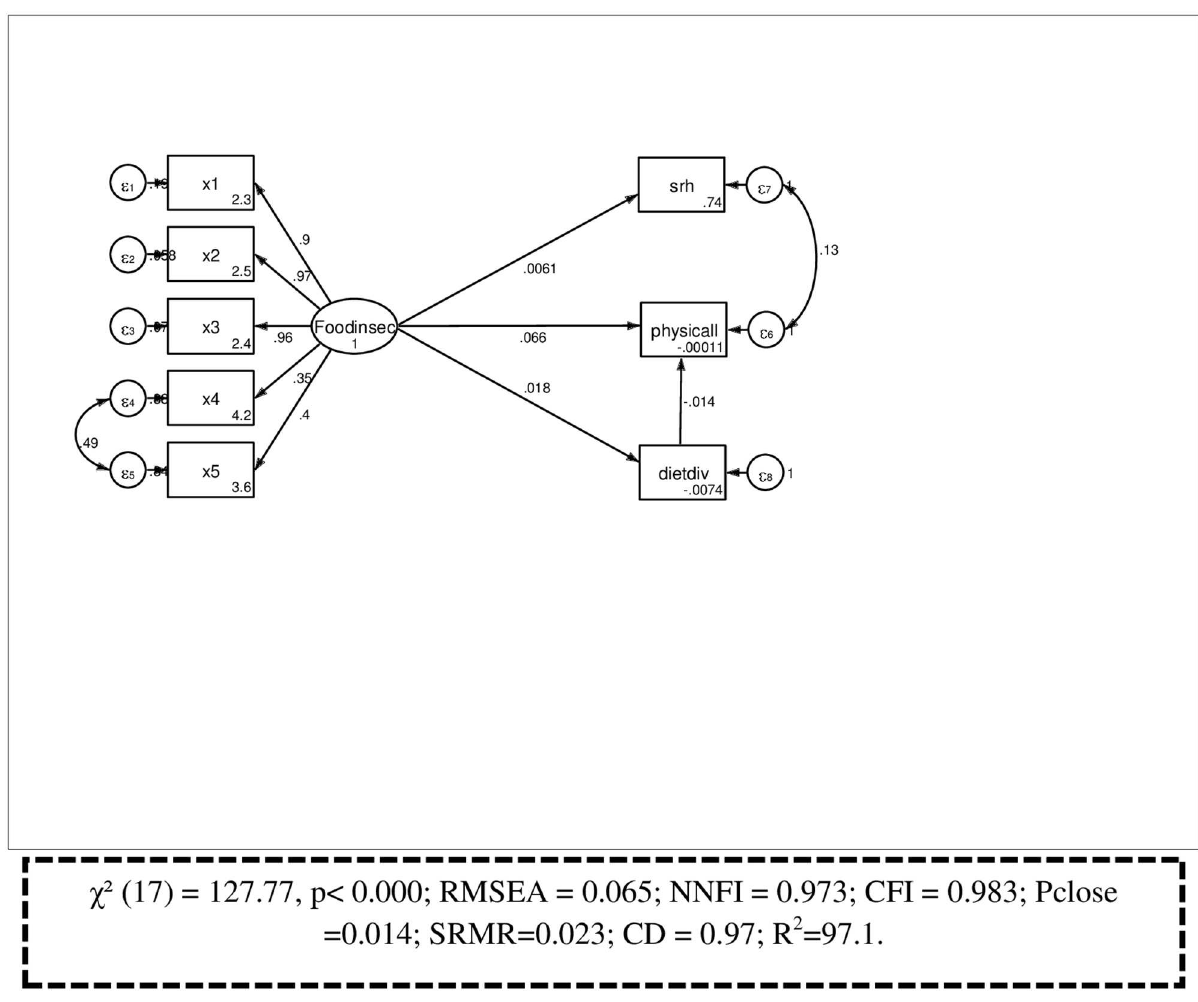
Fig 4. Measurementmodel of constructs, Jimma Longitudinal Family Survey of Youth, Southwest Ethiopia, 2015.